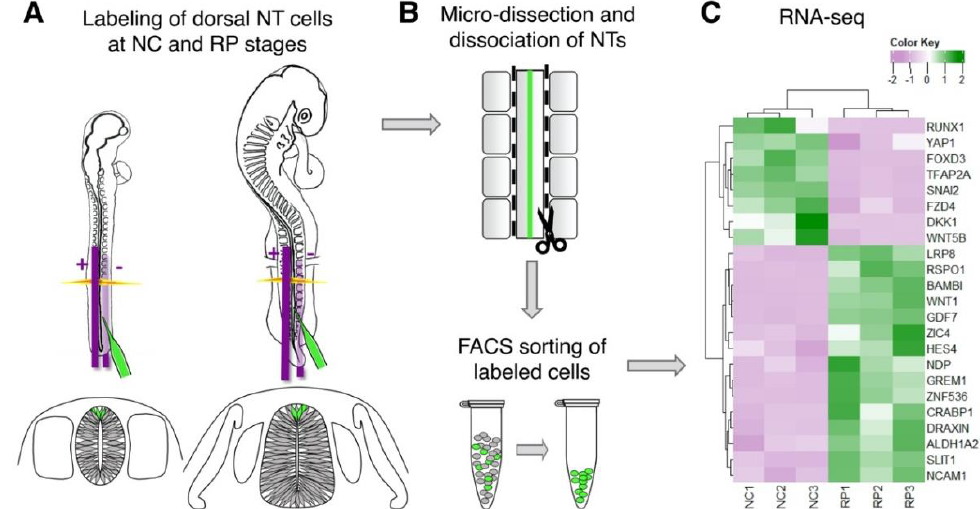
Figure 2. Schematic representation of a transcriptomic analysis comparing premigratory NC to RP. ( A ) Electroporation of GFP-DNA (green) was directed ventro-dorsally from the negative (-) to the positive (+) poles to label cells in the dorsal region of the quail NT at either the NC or the RP stage. ( B ) Transfected NTs were isolated, and dissociated into single cells, followed by FACS sorting. ( C ) RNA-seq analysis of fluorescent cells was performed in triplicate samples and reveals differential gene expression between premigratory NC and definitive RP cells.